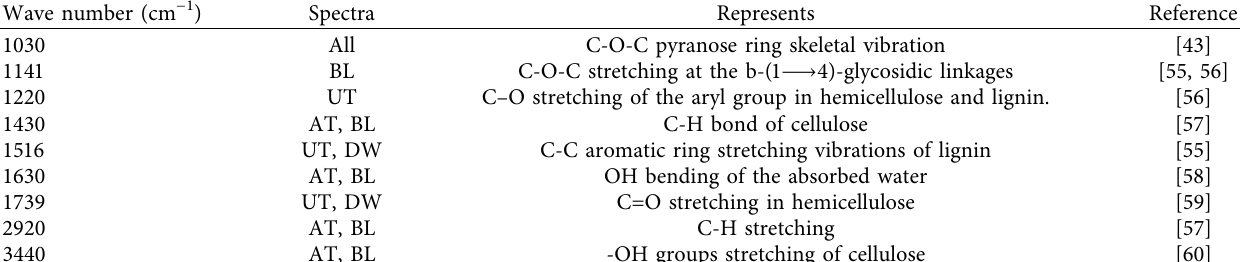
Table 3: Te IR spectra of detected peaks and their